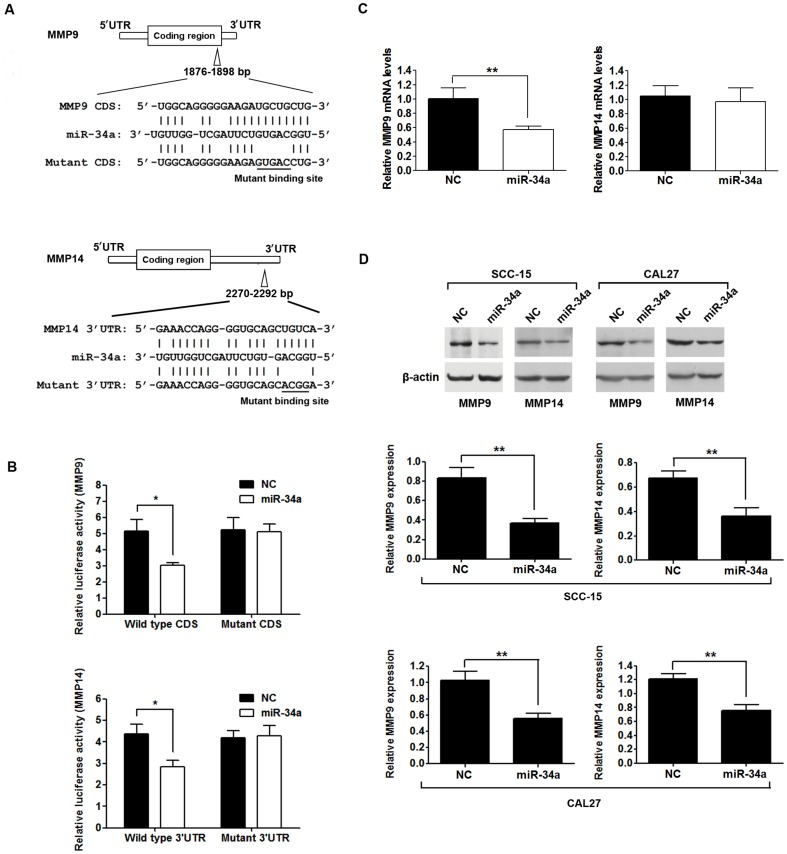
miR-34a targets MMP9 and MMP14.(A), The sequence of miR-34a (middle) matches the coding sequence (CD) of MMP9 and 3′untranslated region (UTR) of MMP14 (top). Bottom, mutations of the CD of MMP9 and 3′UTR of MMP14. (B), miR-34a inhibited wild-type, but not mutated MMP9 CD and MMP14 3′UTR luciferase reporter activity. CAL27 cells were co-transfected with firefly luciferase reporter plasmids containing wild type or mutant MMP9 CD and MMP14 3′UTR, and pRL-TK plasmid (a plasmid expressing rellina luciferase) and pcDNA3.0-miR-34a (miR-34a) or pcDNA3.0 (NC) as indicated. After 24 h, firefly luciferase activities were measured and normalized by use of renilla luciferase activities. Data were presented as mean ±SD (*
P<0.05). (C), The relative MMP9 and MMP14 mRNA levels determined by qRT-PCR in miR-34a or NC transfected CAL27 cells (*
P<0.01). (D), Inhibition of the expression of MMP9 and MMP14 proteins. Representative Western blotting image (top) and the quantification (bottom) of MMP9 and MMP14 proteins in miR-34a transfected SCC-15 and CAL27 cells. β-actin was used as internal control and was also detected by Western blot (**
P<0.01).